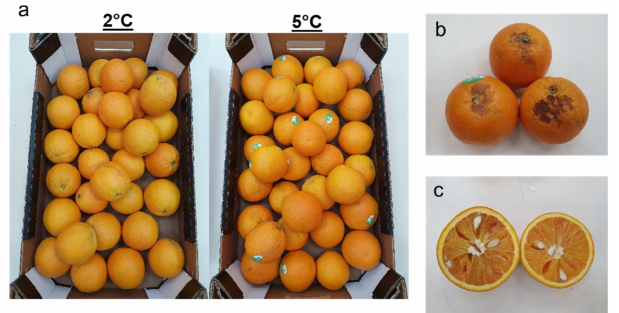
Figure 2. Photographs of ‘Valencia’ oranges. ( a ) Fruit stored at 2 ◦ C and 5 ◦ C, ( b ) peel damage, and ( c ) internal dryness symptoms.